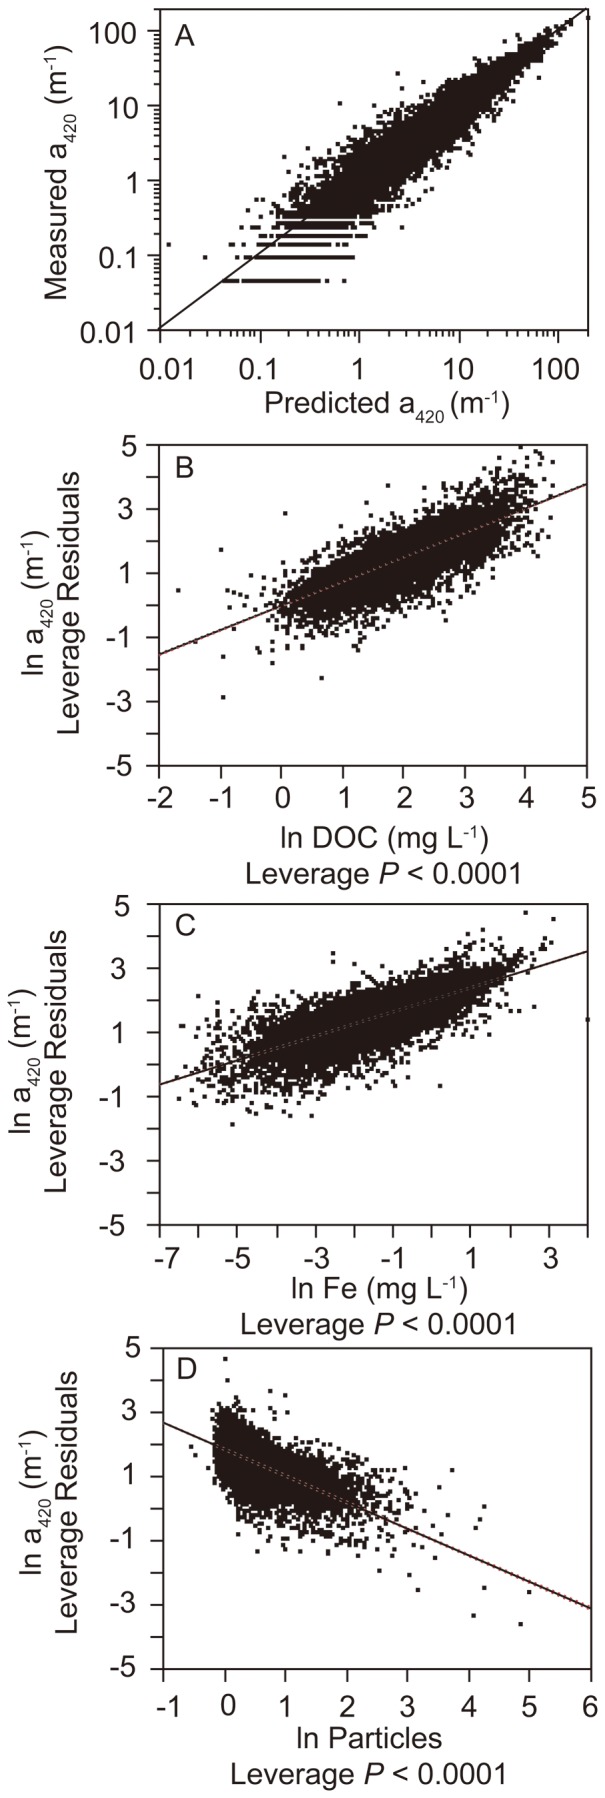
Prediction of absorbance (a420) by dissolved organic carbon (DOC), iron (Fe) and particulate matter (particles) for 46787 Swedish water samples.Particulate matter was assessed by the absorbance ratio between unfiltered and filtered water (see methods). 92% of the a420 variations could be explained by the simple standard least squares model (panel A; a420 = e(0.73+0.76·lnDOC+0.38·lnFe−0.83·lnParticles)) where all three input variables made a significant contribution to the model performance, here shown by model leverage plots (panels B–D). Removing the input variable particles from the model, the model performance decreased to R
2 = 0.85, P<0.0001, n = 46787. Using only DOC as input variable the model performance was R
2 = 0.73, P<0.0001, n = 46787.